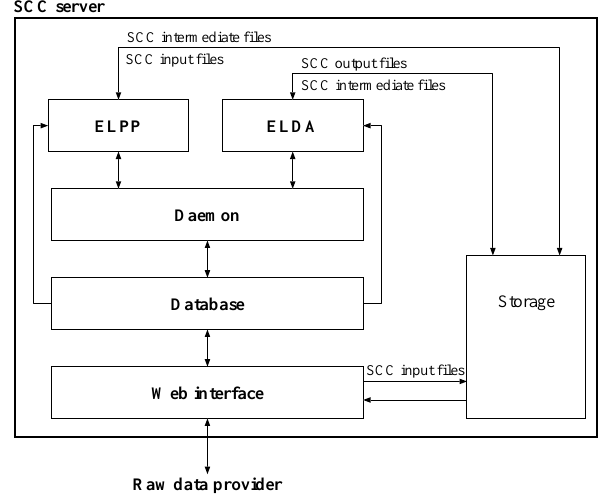
Figure 1. Block structure of the Single Calculus